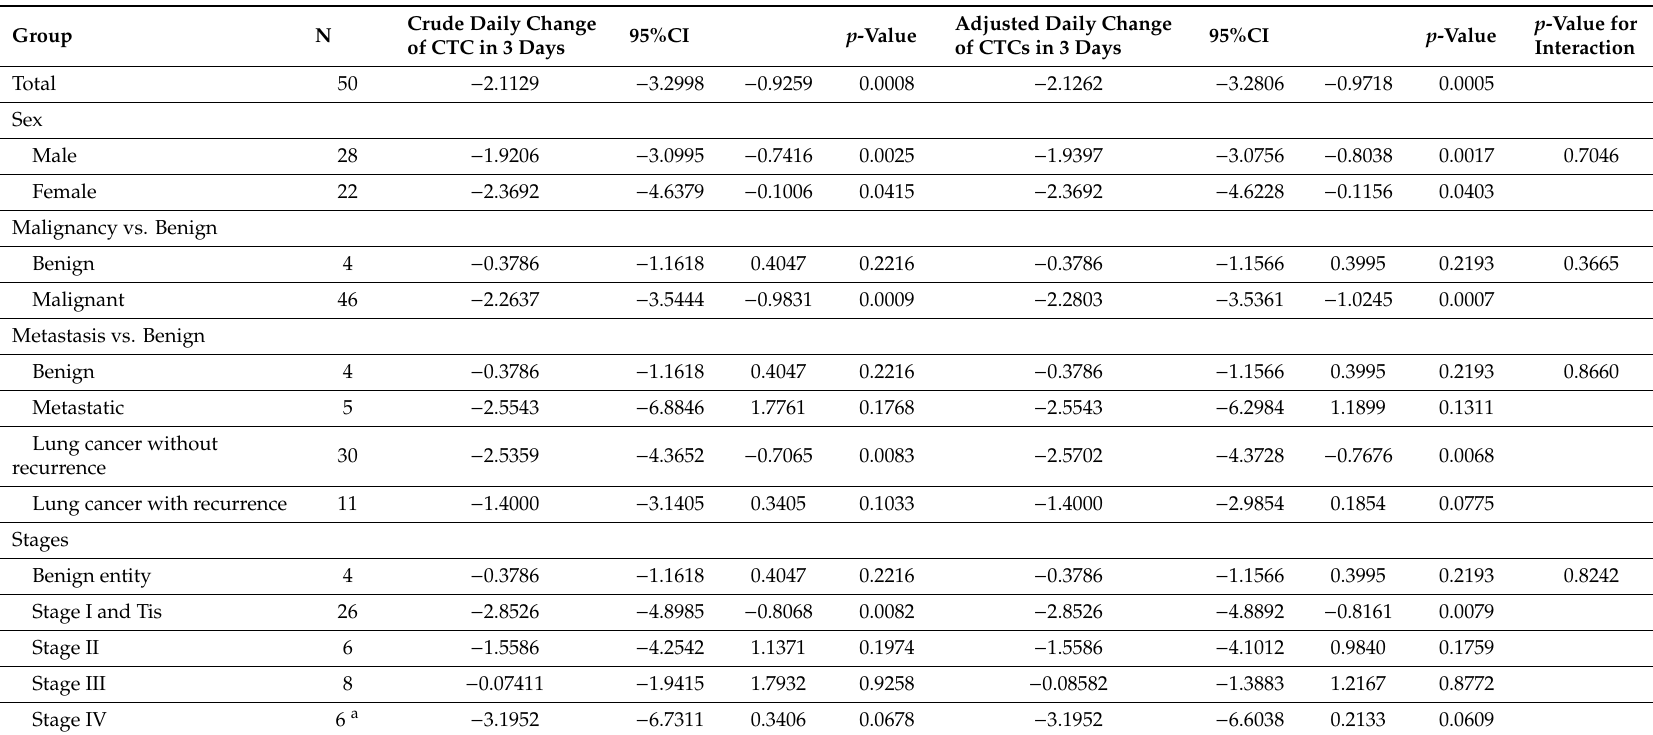
Table 4. Crude and adjusted daily decline among di ff erent